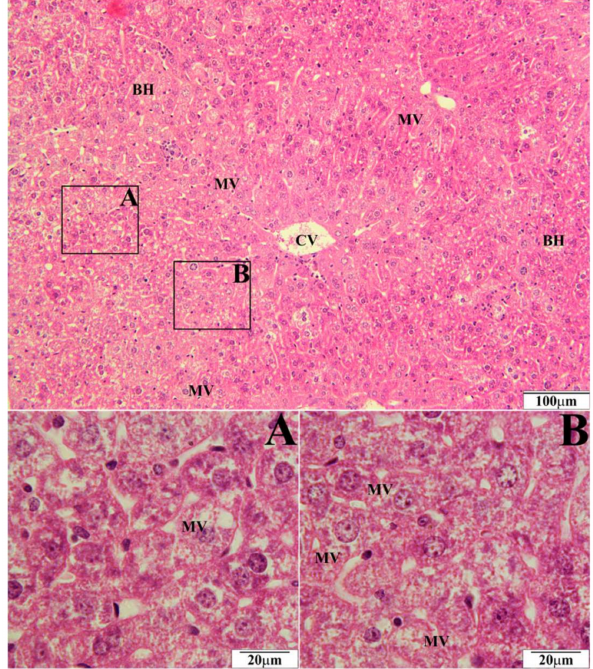
Figure 2. Representative section of the liver of C 57 BL 6 mice on a high-fat diet supplemented with bee pollen ethanol extract (EEP) in the dose of 0.1 g/kg BM (HFD-0.1). Slides stained with Hematoxylin and Eosin. CV—central vein, BH—ballooned hepatocytes, MV—microvesicular fatty